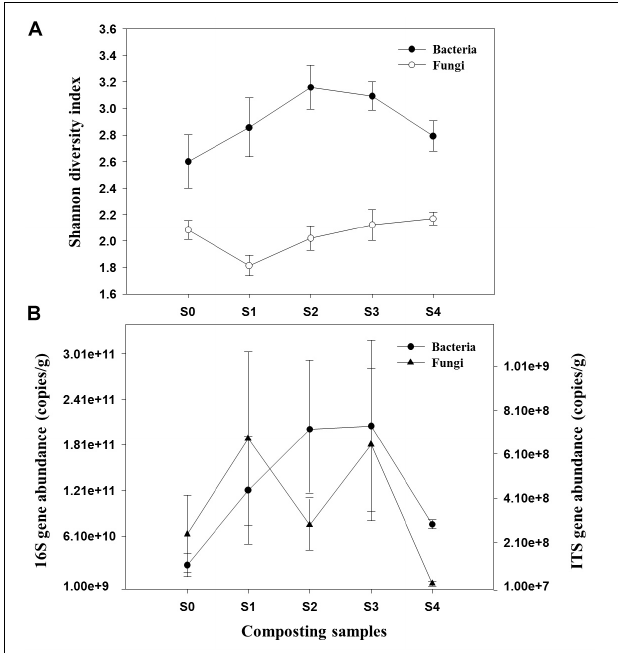
FIGURE 1 | Shannon diversity index of bacterial and fungal communities (A) and abundance of 16S rRNA gene and ITS gene (B) during composting process.